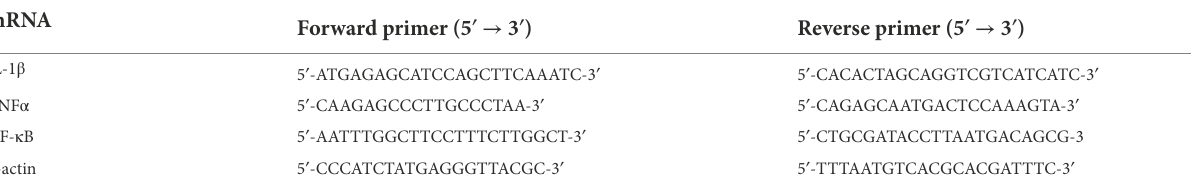
TABLE 1 Primer sequences in